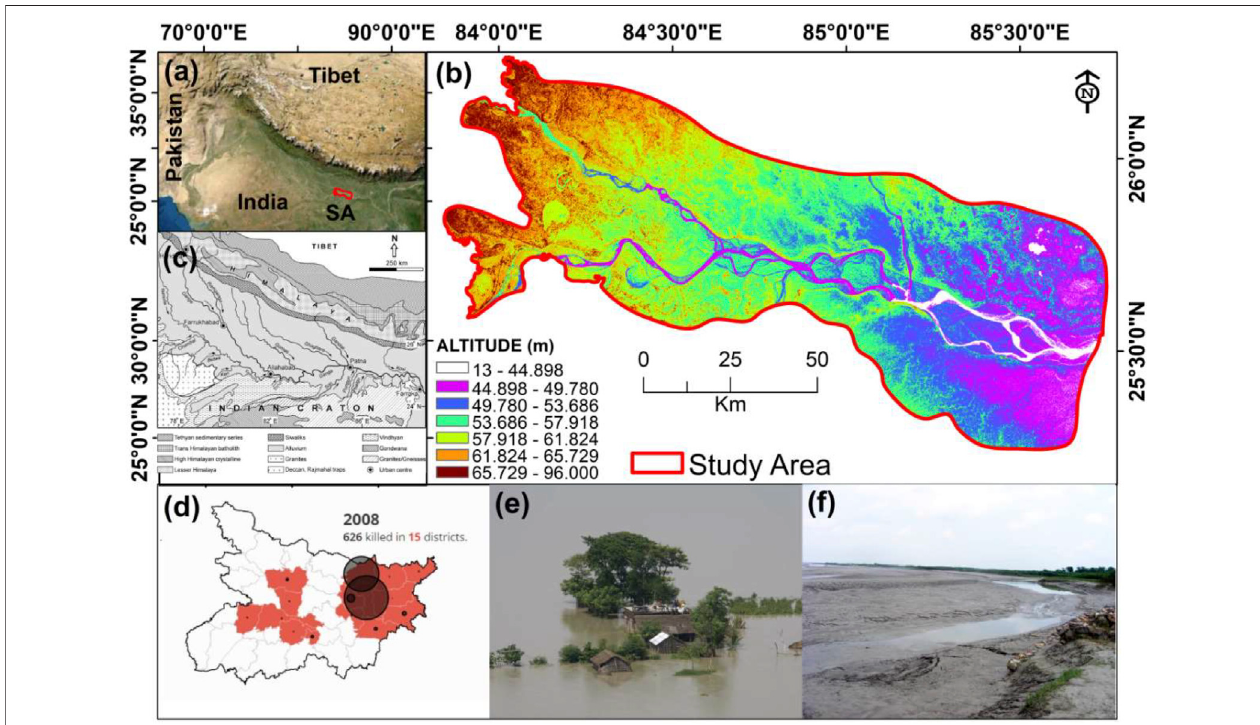
FIGURE 1 | Location of the study area. (A) : Location of the studied area marked on the map of India. It also shows Tibet and Pakistan in the northeastern and northwesternsidesrespectively. (B) :Elevationofthestudyareaclassi fi edusingNaturalBreak(NB)methodwithinputfromSRTM30mdigitalelevationmodel. (C) :broad beological pro fi le of the study area and its surroundings. This section also shows major drainages of the Ganga River Basin of which our study area is a part. (D) Loss of lives due to 2008 Bihar fl oods in 15 districts is shown here. (E,F) are photographs of the fl ood situation in the study area. (E,F) : fi eld photographs captured in the study area caused by 2008-Bihar fl